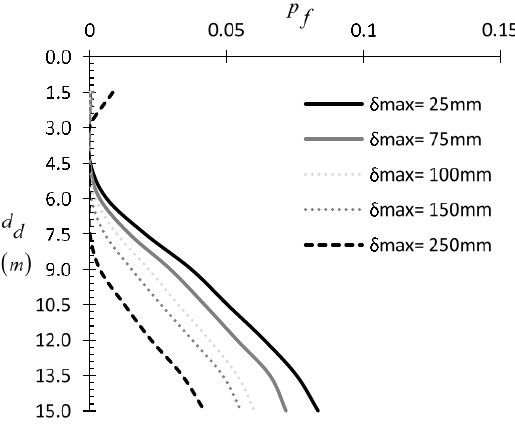
Figure 8. p f vs. d d curves for various δ max values; chart referring to the SLS state.